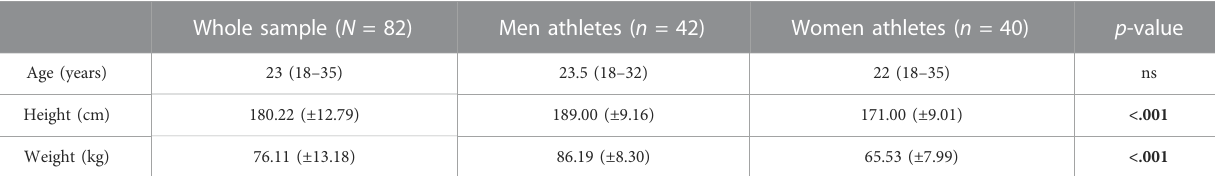
TABLE 1 Demographic data for all athletes and split by gender.